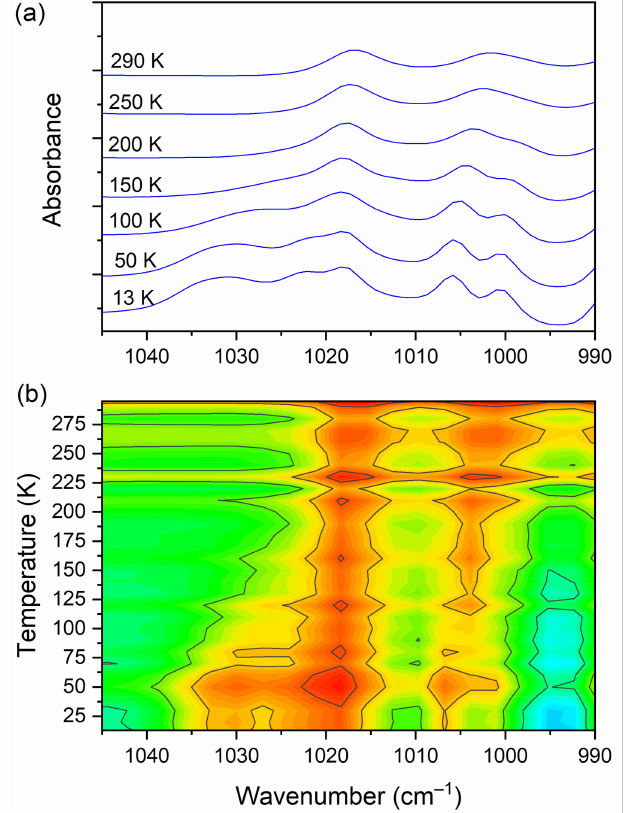
Figure 10. ( a ) IR spectra in the wavenumber range of 1045–990 cm − 1 during cooling of the N,N- dimethylglycine–chloranilic acid co-crystal; ( b ) contour plots of IR spectra in the C − N str. , CH 3 rock. , CH 2 rock. (DMG + ) vibration